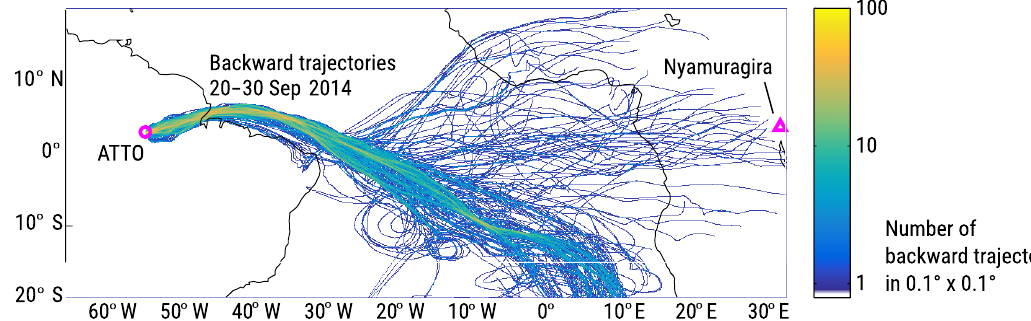
Figure 5. Density of 15-day backward trajectories started from ATTO at an altitude of 300ma.m.s.l. every hour starting at 00:00UTC on 20 September 2014 to 23:00UTC on 30 September 2014.